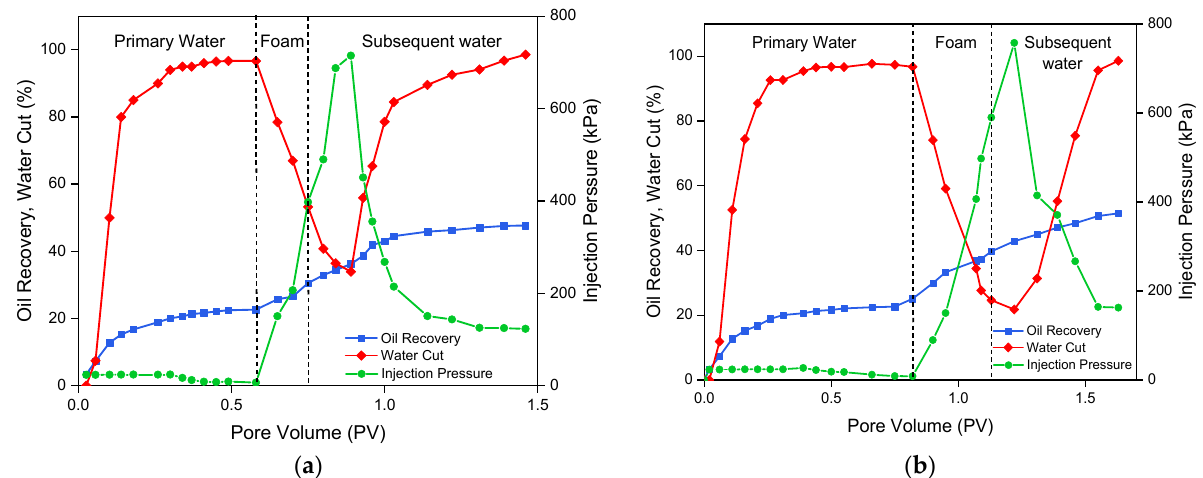
Figure 9. The influence of the three-phase foam slug size on oil displacement in parallel cores of permeability ratio 10: ( a )